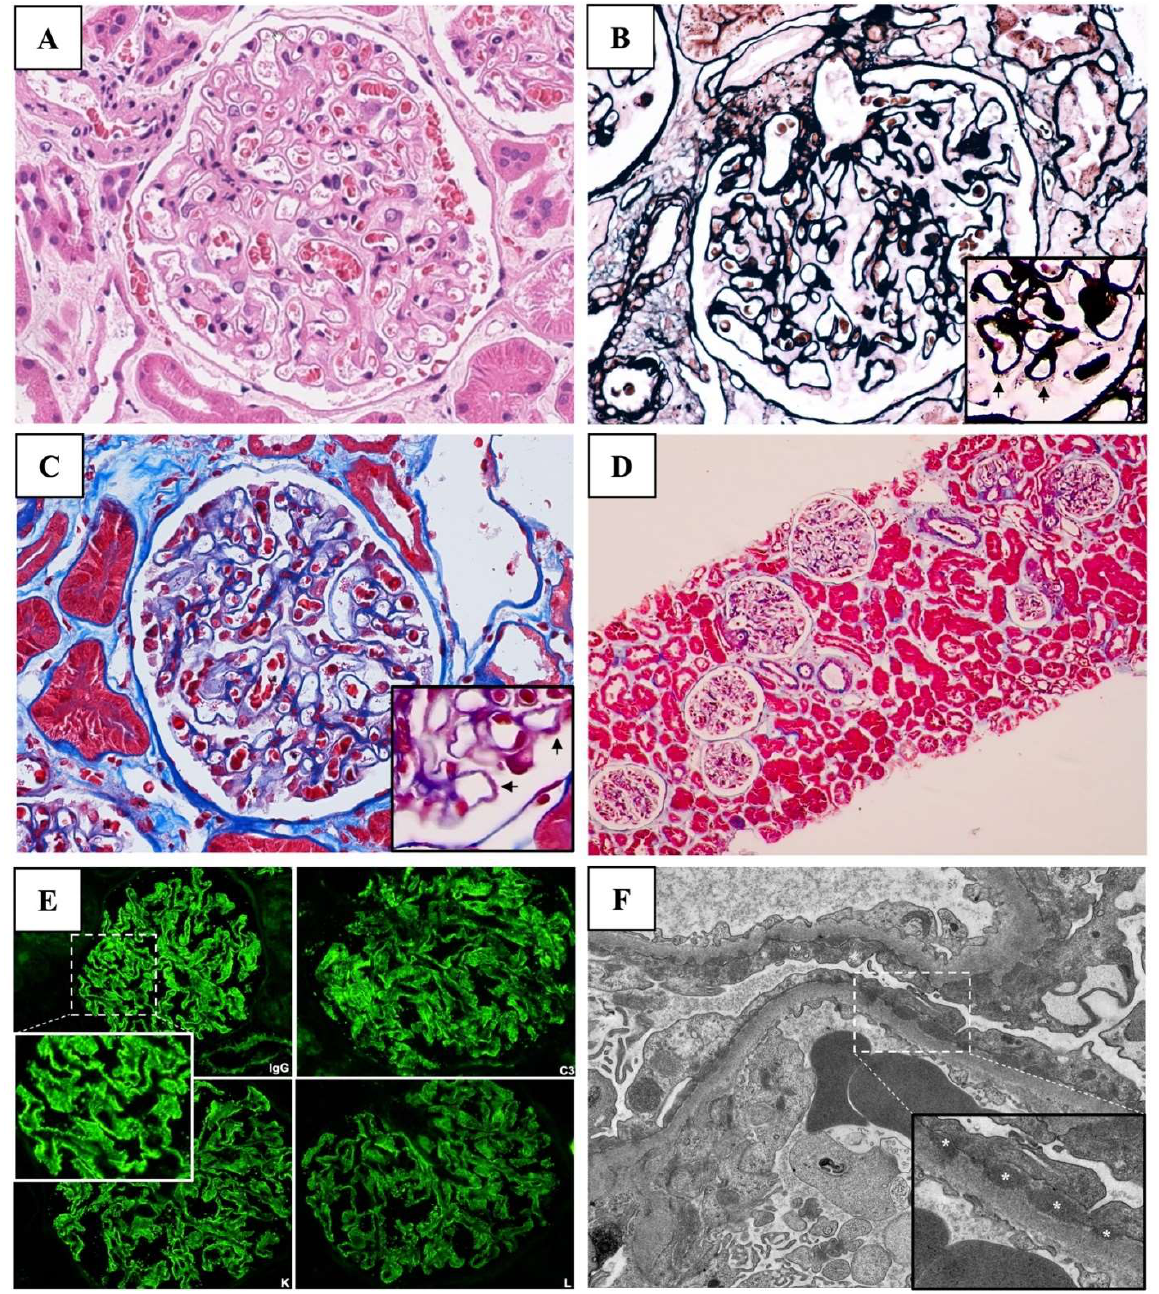
Figure 1. Kidney biopsy findings. ( A ) Light microscopy of the glomerulus with Hematoxylin and Eosin (original magnification, ×200) revealed normal glomeruli. ( B ) Jones silver stain (original magnification, ×200) showed focal spike formation on the glomerular basement membranes (arrows). ( C ) Masson trichrome stain (original magnification, ×200) depicts the subepithelial fuchsinophilic granules (arrows). ( D ) Masson trichrome stain (original magnification, ×4) revealed diffuse interstitial edema without accompanying tubular injury and interstitial inflammation. ( E ) Direct immunofluorescent studies demonstrate diffuse granular deposition with strongly positive (3+) stains for IgG, C3, kappa, and lambda with negative stains of IgA, IgM, and C1q. ( F ) Electron microscopy (original magnification, ×5000) revealed numerous subepithelial electron-dense deposits (asterisks) and a few small deposits in mesangial, intramembranous, and subendothelial area with podocyte foot process effacement (magnification, ×10,000). * denotes electron-dense deposits under electron microscopy